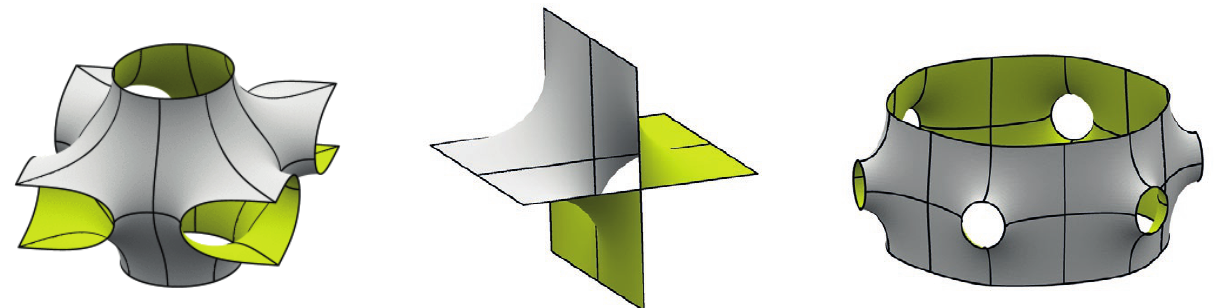
Figure 26. Unit cells of some IPMS (left to right): S’-S’’ surface (genus 4), CLP surface, H’-T surface (both genus 3). Images courtesy of Ken Brakke.